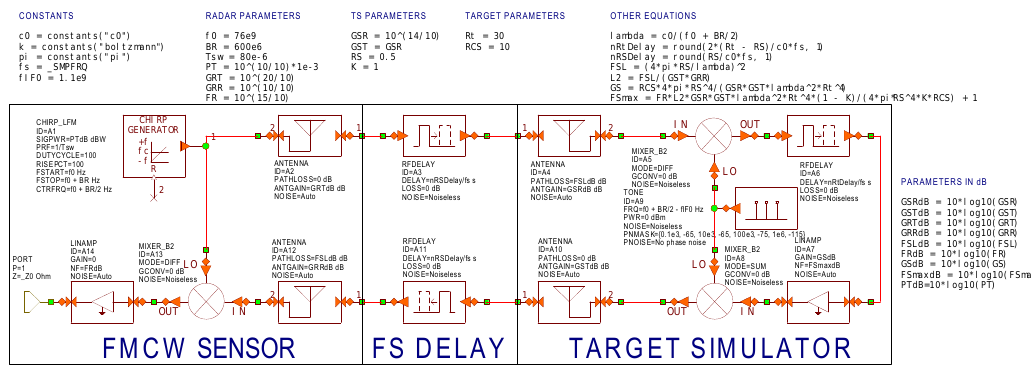
Figure 11. AWR Visual System Simulator schematic used for the analysis of the FMCW radar with the TS simulating a single artificial target. The radar model consists of the chirp generator A1, mixer A13 and transmitting and receiving antennas A2 and A12. The radar–TS round-trip delay is simulated by blocks A3 and A11. The TS model consists of receiving and transmitting antennas A4 and A10, and down- and up-converting mixers A5 and A8, with the shared local oscillator A9. Range of a single target is set by delay block A6 and its RCS by amplifier A7.